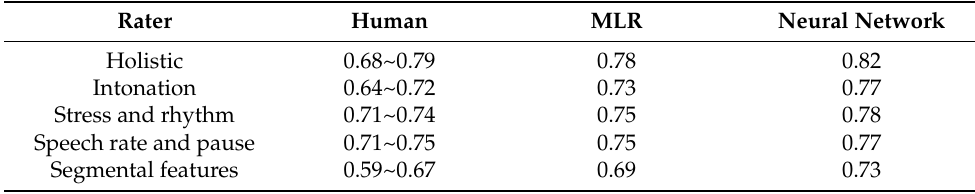
Table 7. Correlation between human rater and proposed proficiency scoring system without data